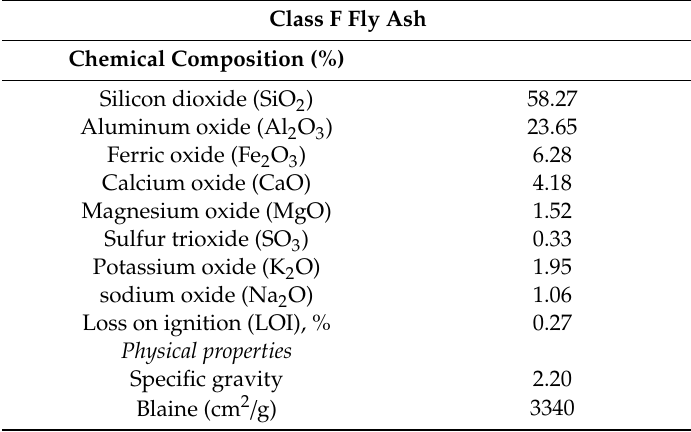
Table 1. Properties of fly ash.